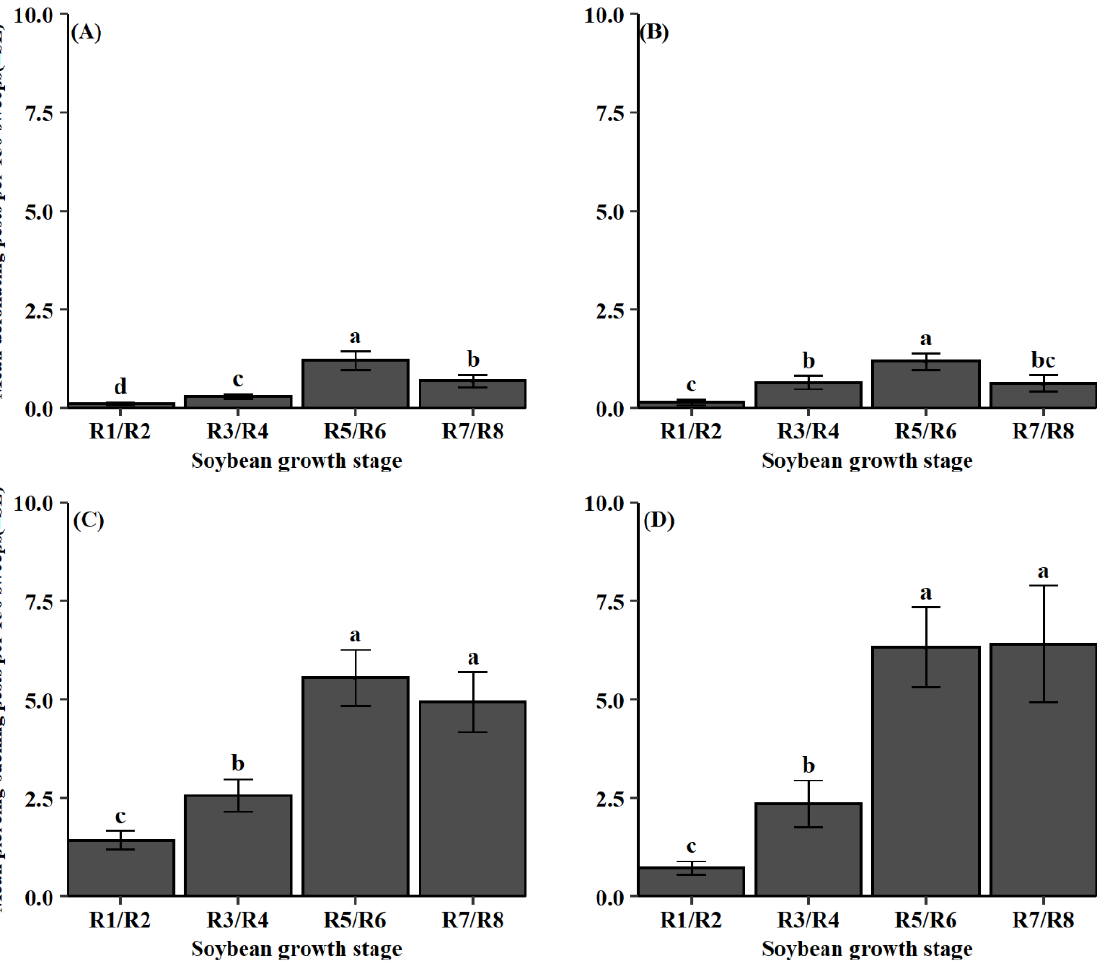
Figure 2. Mean pest count per 150 sweeps ( ± SE) for observed soybean growth stages of collected defoliating pest groups in datasets ( A ) 2012–2014 and ( B ) 2015–2018; piercing-sucking pest groups in datasets ( C ) 2012–2014 and ( D ) 2015–2018. Same letter denotes no significant difference between means ( p > 0.05).